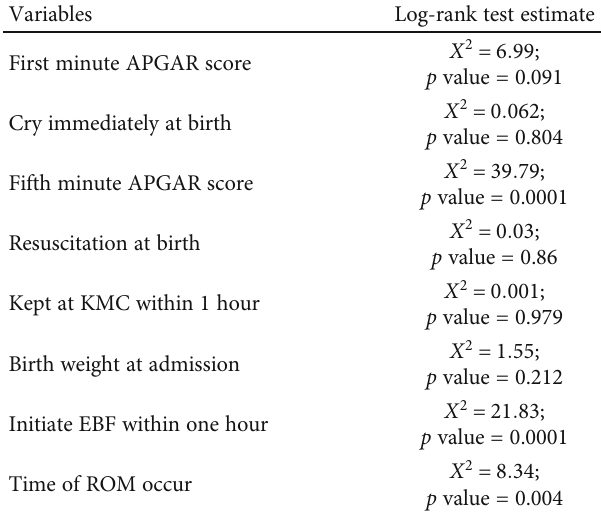
Table 4: Log-rank estimate of variables on mortality of neonates with neonatal sepsis at public hospitals in